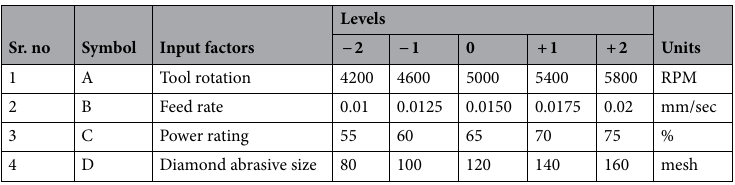
Table 2. Different levels of paremeters.